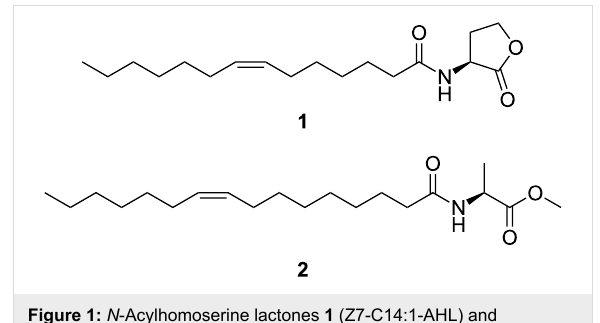
Figure 1: N -Acylhomoserine lactones 1 (Z7-C14:1-AHL) and N -acylalanine methyl esters 2 (Z9-C16:1-NAME) occurring in Roseobacter group